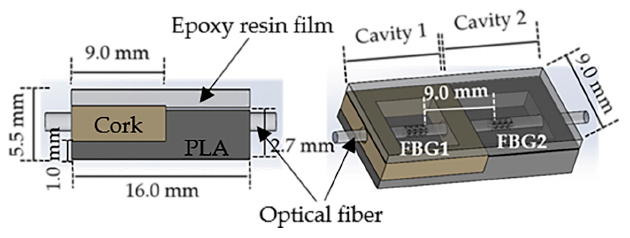
Figure 1. Schematic illustration of the designed sensing cell for simultaneous vertical forces (F V ) and shear forces (F S ) measurement.